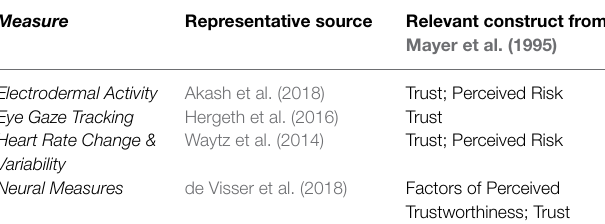
TABLE 5 | Physiological measures of trust.